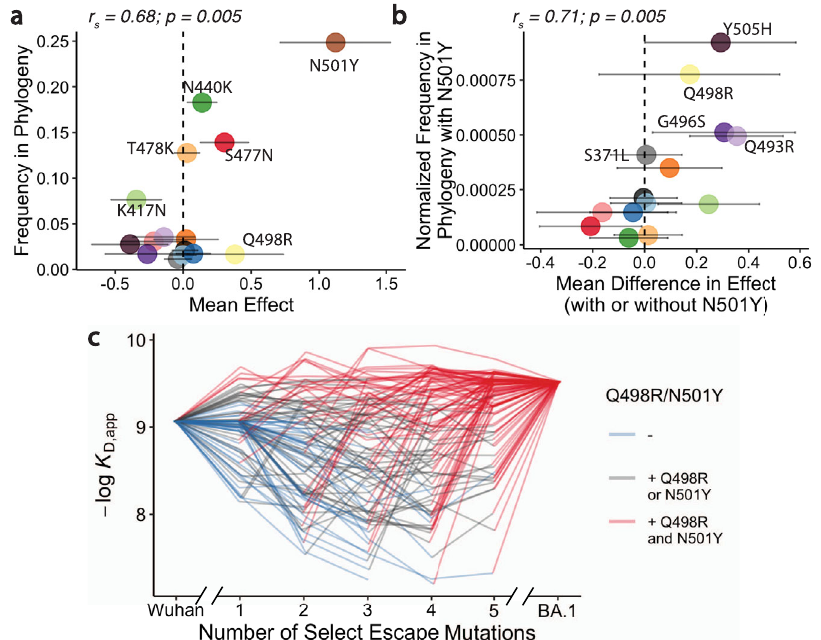
Fig. 4 | Trajectory of Omicron BA.1 evolution. a Frequency of occurrences for each mutation across SARS-CoV-2 sequences available on GISAID (see “ Meth- ods ” ) as a function of their average effect on ACE2 af fi nity in our data. Error bars indicate standard deviation of effect sizes and are centered on the mean (n=16384 backgrounds). The Spearman ’ s rank correlation coef fi cient (r s ) is indicated in the top-left. ( b ) Normalized frequency of mutations co-occurring with N501Y across SARS-CoV-2 sequences available on GISAID (calculated based on the frequency at which each mutation occurs on the same branch as N501Y, normalized by their overall frequency; see “ Methods ” ) as a function of the